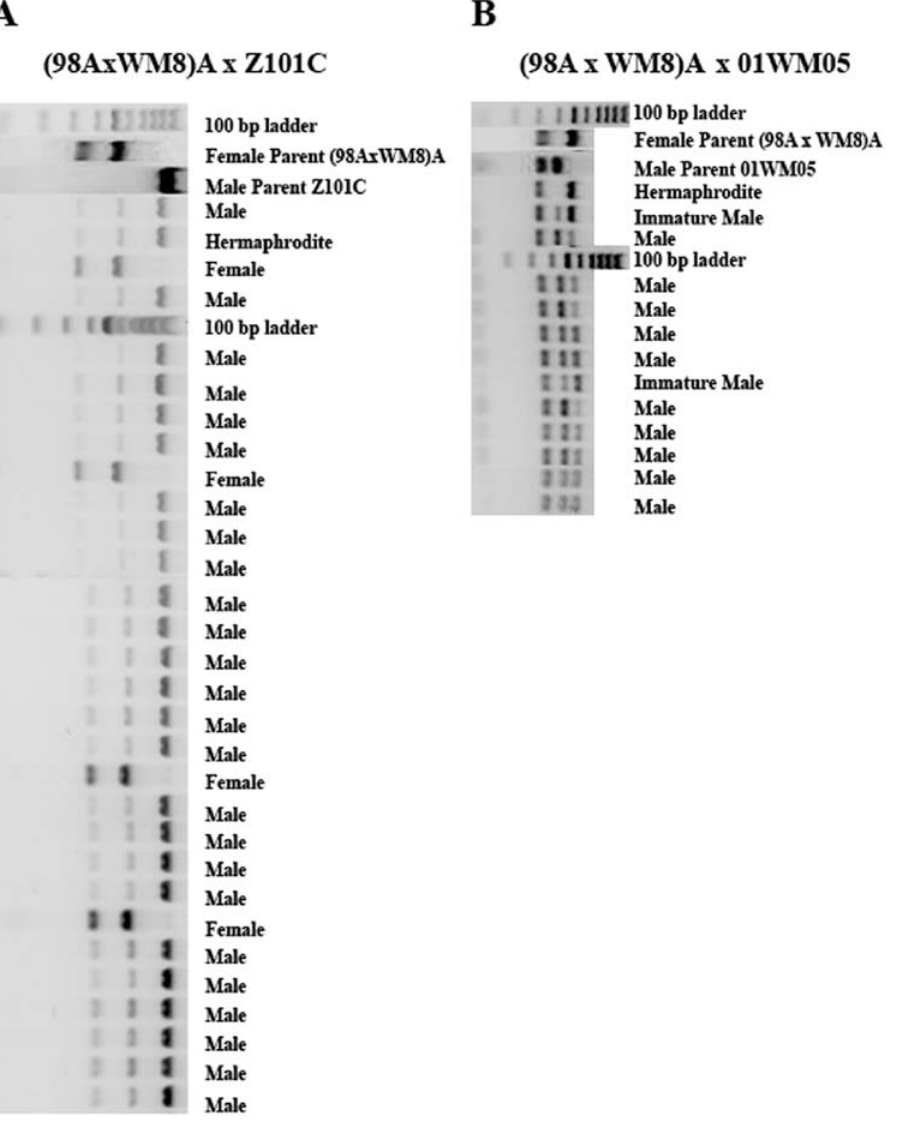
Figure 2. mtDNA content and sex of progeny of a male-biased mother crossed with a male of its own or of a different species. A) Homospecific cross. The majority of progeny are males (25 out of 30). These progeny and the single hermaphrodite carried the mtDNA of both parents. Four progeny were females and contained only the mother’s mtDNA. B) Hybrid cross. All progeny, but one, were males and all carried the mtDNA of both parents. The single hermaphrodite carried only the mother’s